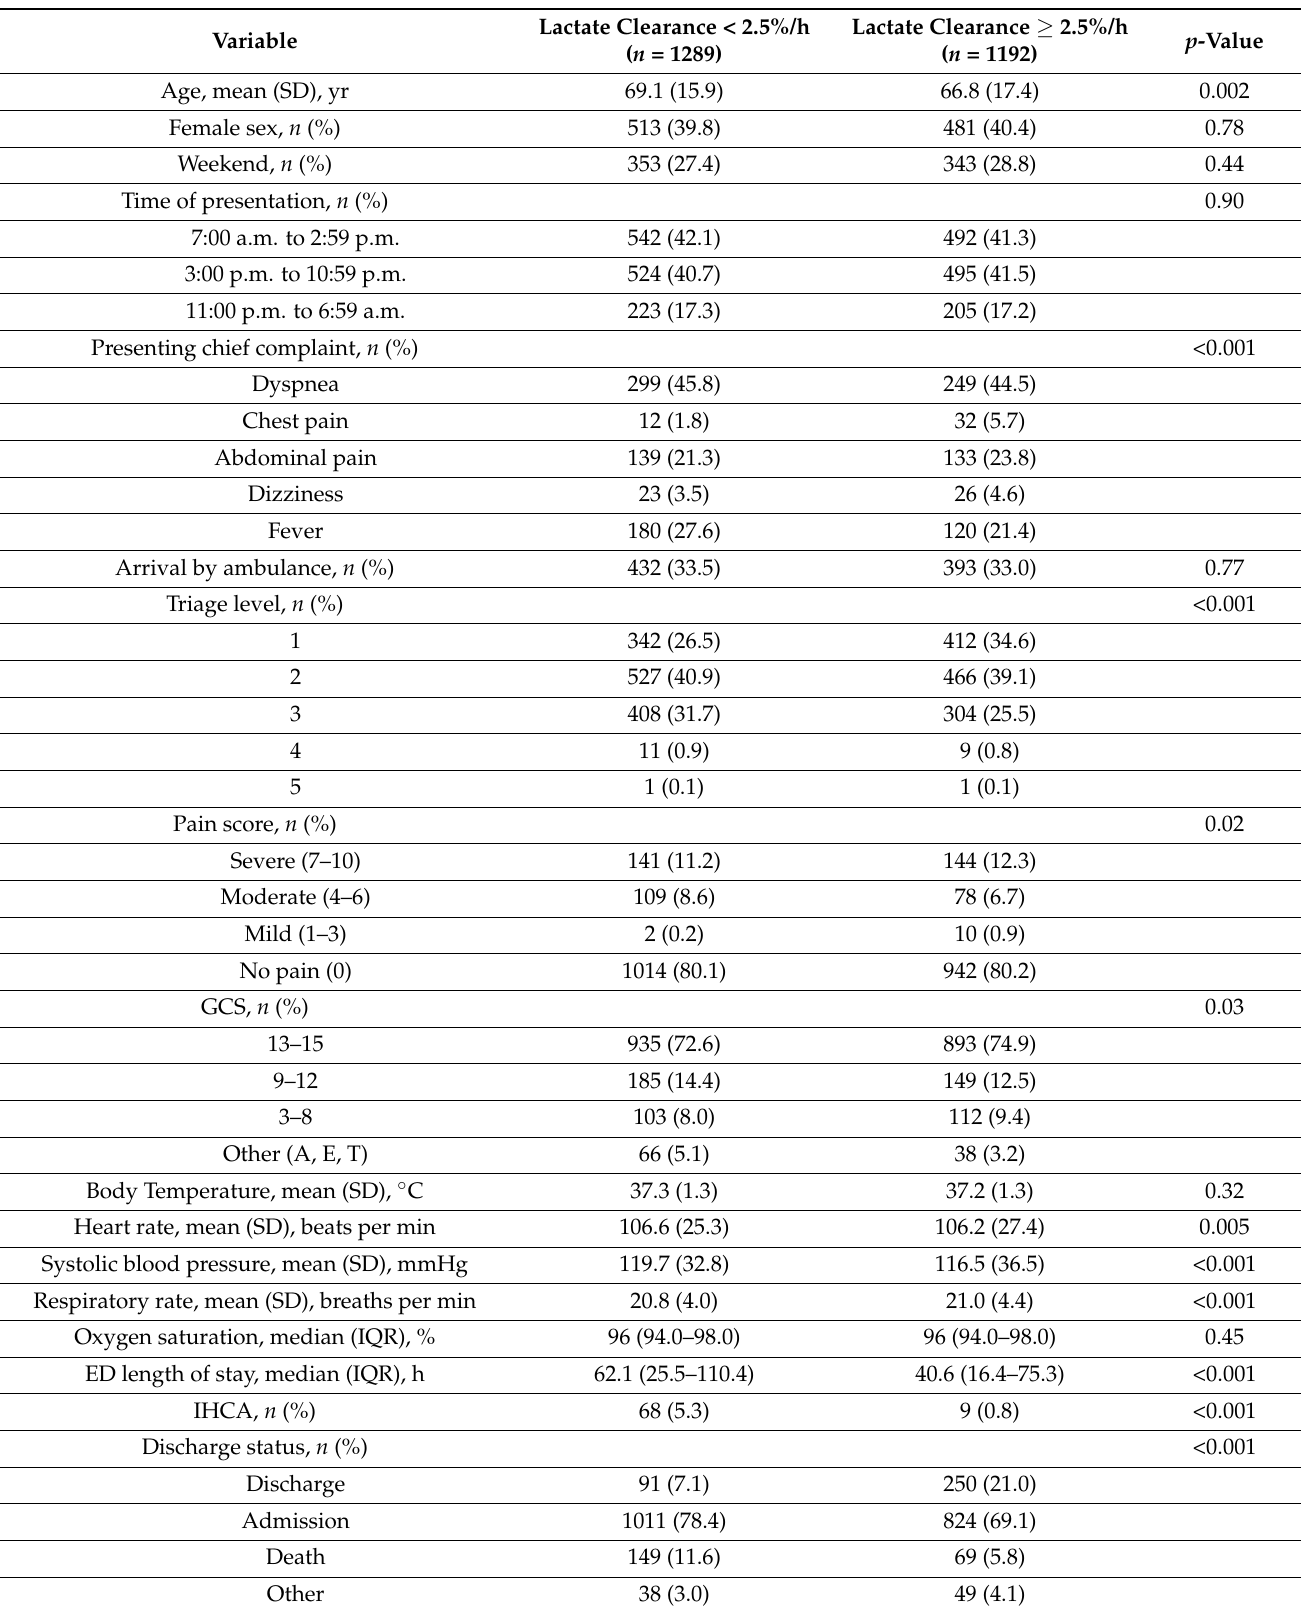
Table 4. Baseline clinical characteristics and outcomes by lactate